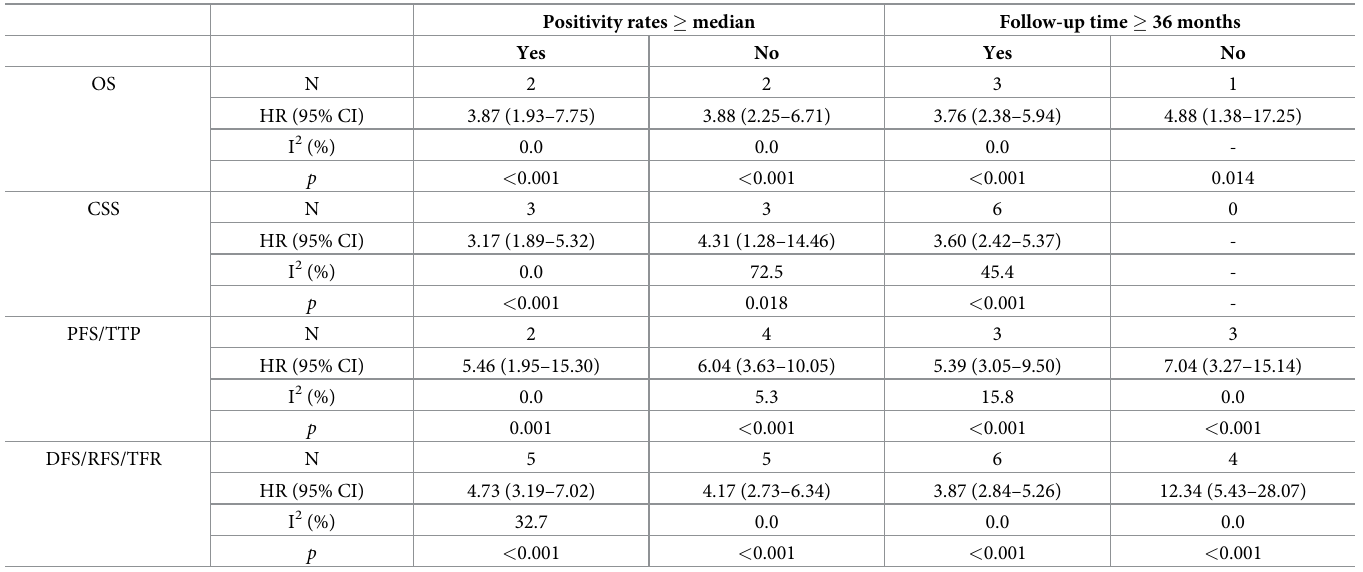
Table 4. Subgroup analyses of HRs based on different positivity rates and follow-up